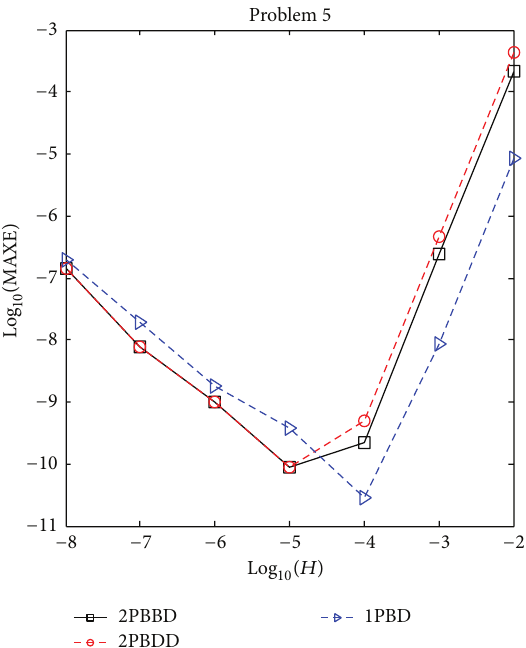
Figure 10: Graph of Log 10 ( MAXE ) plotted against Log 10 (𝐻) for Problem 5.